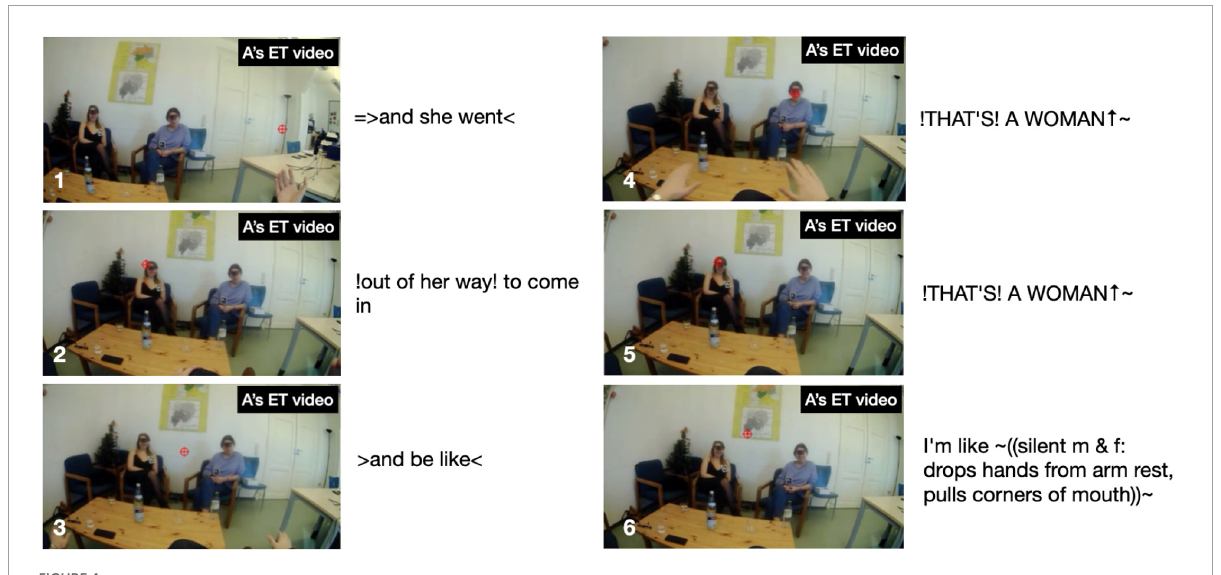
FIGURE4 Storyteller’s gaze locations during the Climax in “Toilet